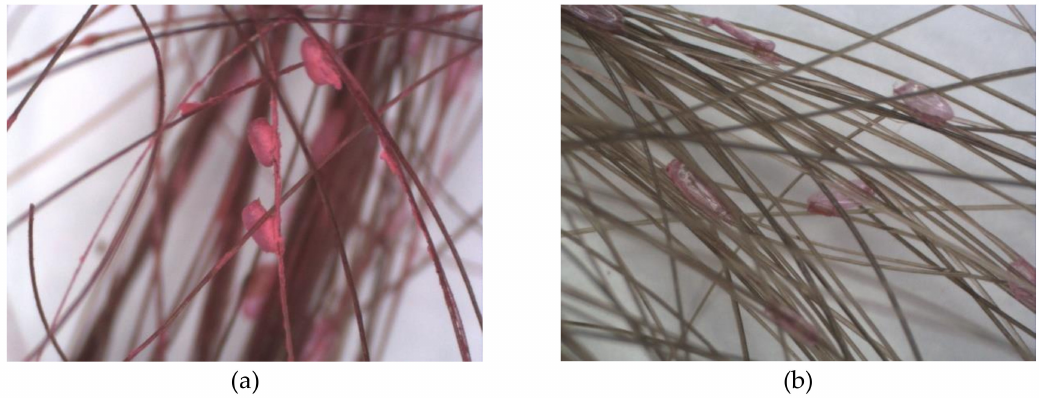
Figure 1. Nits stained with Neon Nits ® Lice Egg Locator Spray. ( a ) Nits coated with pink spray residue immediately after application; ( b ) Treated nits after vigorous brushing and washing to remove spray powder